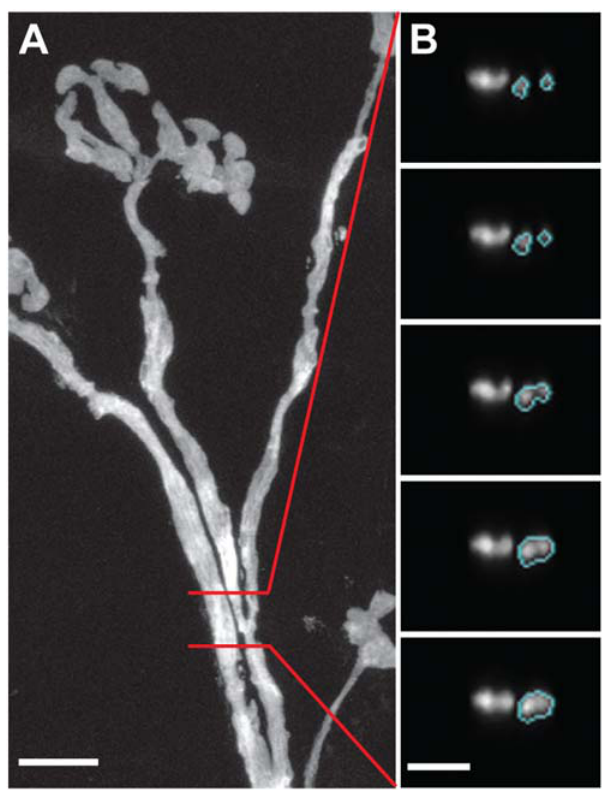
Figure 3. Example of a branching axon. A . Maximum intensity projection of an axon that branched between the two red lines. Scale bar: 10 m m. B . The axonal branching point shown in cross-sections. Scale bar: 5 m m.